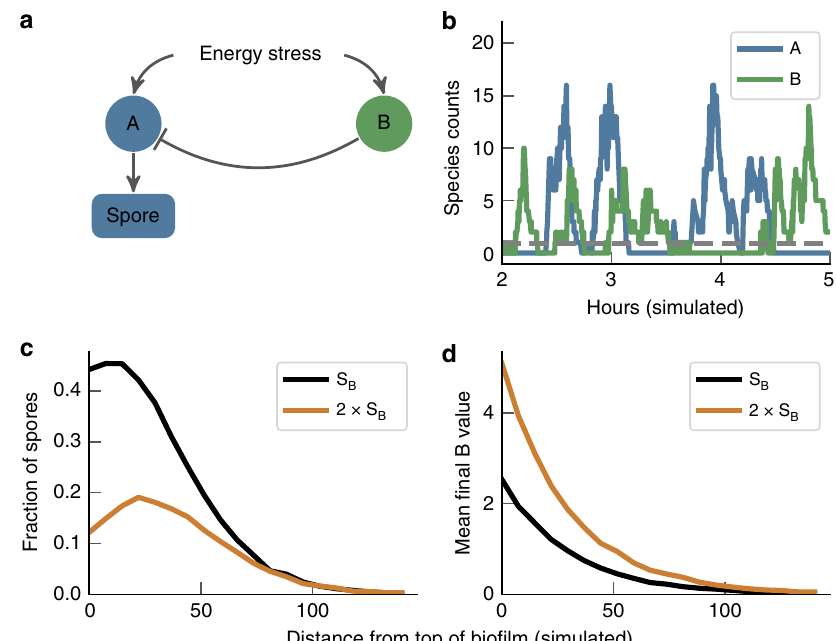
Fig. 6 A simple model predicts suppression of sporulation at the top of the bio fi lm with increased pulse frequency of σ B . a Model network diagram. b Example traces of species a and b exhibiting pulses at the top (distance 0) of the simulated bio fi lm. The grey dashed line is the spore threshold (set at 1 for these parameters. A cell must express A for more than 30 simulated minutes above the threshold value to become a spore. For details see the “ Methods ” section). c Fraction of simulations where the value of species A exceeded the spore threshold for more than 30 simulated minutes where the B pulse frequency parameter s B = 0.25 and with the pulse frequency doubled 2 × s B = 0.5. The A pulse frequency parameter is set to s A = 0.7. d Shows the mean fi nal value of species B , recorded from 10,000 simulations for s B = 0.25 and 2 × s B = 0.5. Source data are provided as a Source Data fi